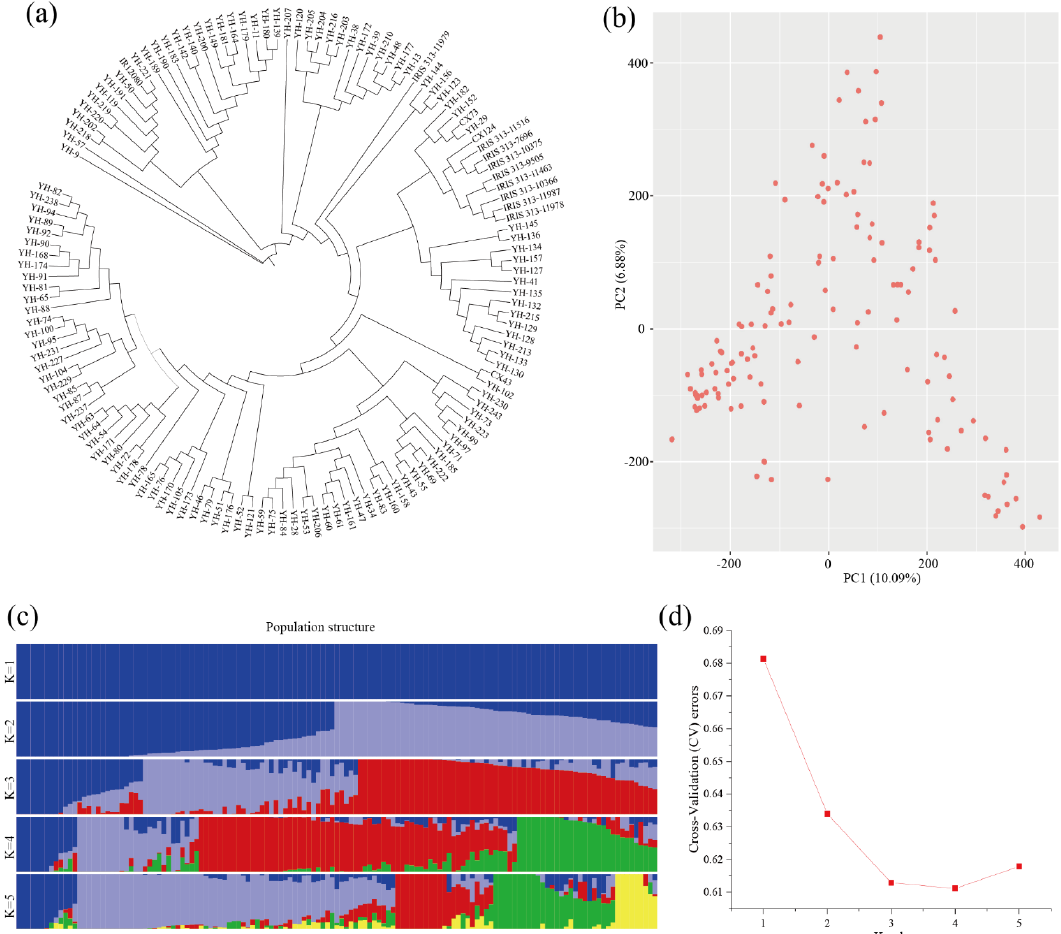
Figure 2. Genetic evolution of natural populations of indica rice. ( a ) Phylogenetic tree; each branch is a rice accession. ( b ) Principal component analysis on 2.89 million SNPs of 137 rice accessions. PC1 and PC2 refer to the first and second principal components, respectively. The numbers in parentheses refer to the proportion of variance explained by the corresponding axes. Red points represent the 137 rice accessions, with each point representing one rice accession. A shorter distance between the points indicates a closer relationship. ( c ) Cluster analysis results of population genotypes, in which each color represents a group and each row indicates a group value. ( d ) Cross validation error rate for each k value. Among them, K is the lowest when k is